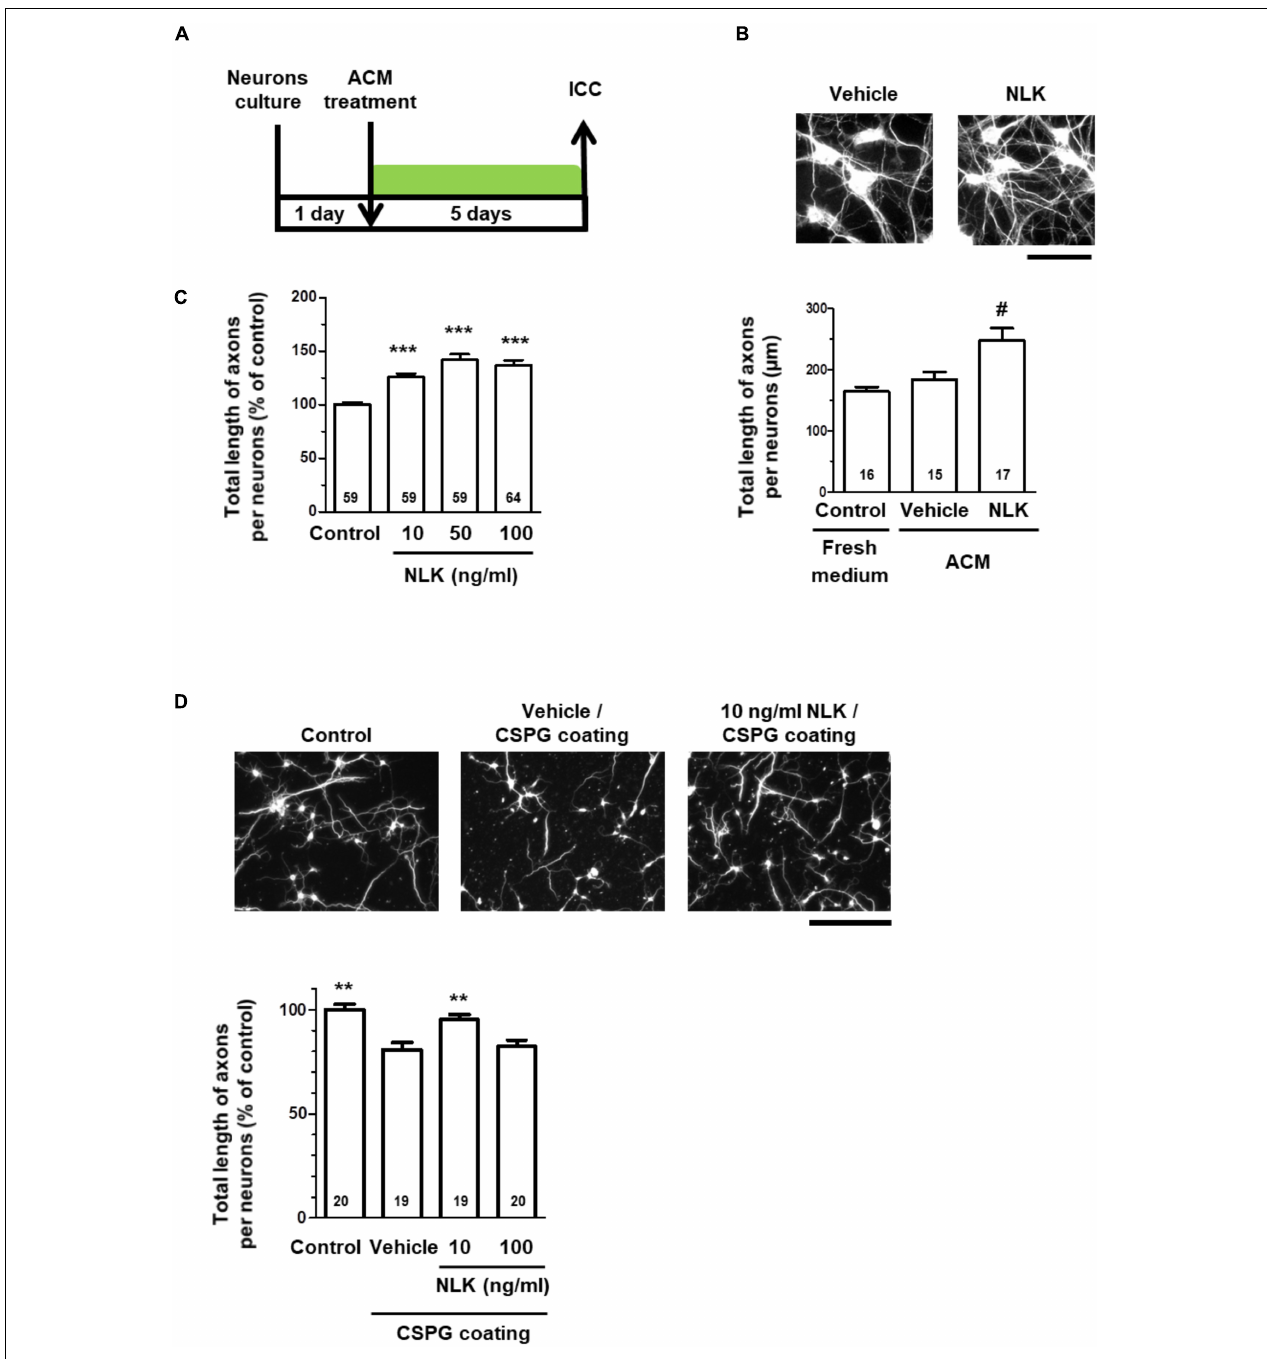
FIGURE 2 | Neuroleukin (NLK) secreted from astrocytes may promote axonal growth in cultured neurons. (A) Cultured cortical neurons were treated with astrocyte conditioned medium in vitro at 1 day post culturing. Five days after the treatment, the cells were fixed and double immunostained for phosphorylated neurofilament-H (pNF-H) and microtubule-associated protein 2 (MAP2). (B) Representative images of pNF-H-positive axons are shown. Scale bar = 100 µ m. Total lengths of pNF-H-positive axons per neuron were quantified for each treatment. # p < 0.05 vs. vehicle, one-way ANOVA post hoc Bonferroni test. Numbers in columns indicate the number of captured images. (C) Cortical neurons were cultured in vitro for 1 day and then treated with recombinant NLK (10, 50, or 100 ng/ml) or vehicle (control) for 5 days. The cells were fixed and immunostained for pNF-H and MAP2. Total lengths of pNF-H-positive axons per neuron were quantified. ∗∗∗ p < 0.001 vs. control, one-way ANOVA post hoc Bonferroni test. Numbers in the graph bars indicate the number of captured images. (D) Cortical neurons cultured in the presence of CSPG were treated with recombinant NLK (10 or 100 ng/ml) in vitro at 1 day post culturing. Four days after the treatment, the cells were fixed and immunostained for pNF-H and MAP2. Representative images of pNF-H-positive axons are shown. Scale bar = 100 µ m. Total lengths of pNF-H-positive axons per neuron were quantified. ∗∗ p < 0.01 vs. vehicle, one-way ANOVA post hoc Dunnett’s test. Numbers in the graph bars indicate the number of captured images.